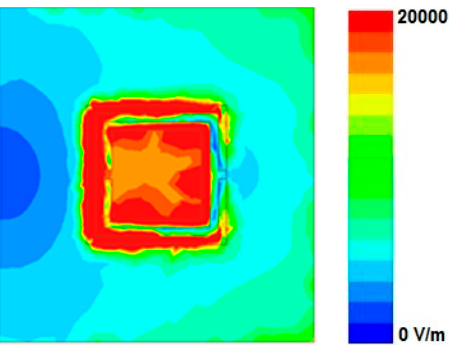
Figure 4. E-field distribution of CSRR-loaded patch at resonant frequency of 4.72 GHz (without microfluidic channel).